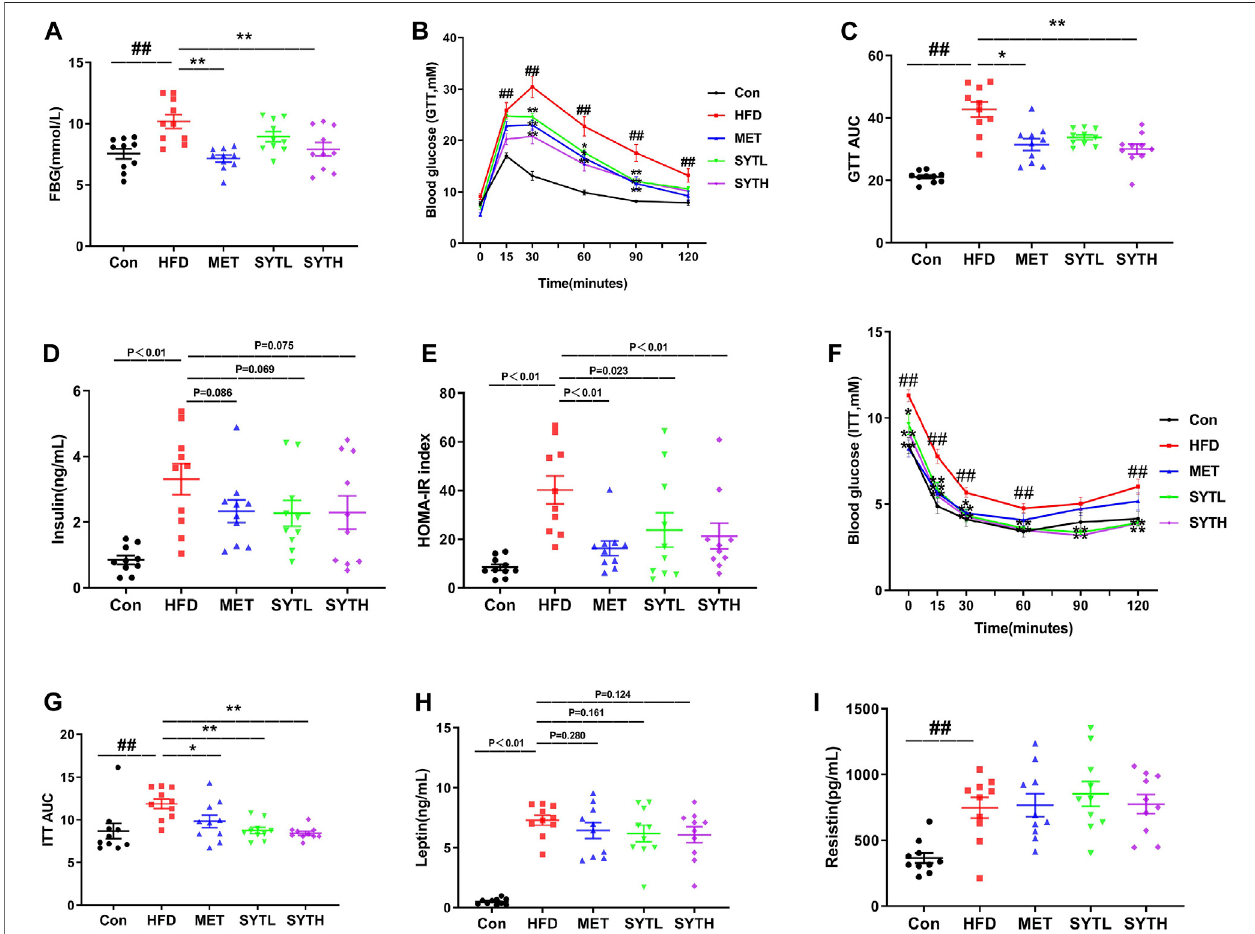
FIGURE 3 | SYT restores glucose tolerance and ameliorates IR in HFD mice. After treatment with SYT for 16 weeks, fasting blood glucose (A) was measured. At 20 w,GTT (B) wasmeasured,andAUCofGTTwasrepresented bydotplots (C) .Seruminsulin (D) and HOMA-IR index (E) weremeasured.ITT (F) wasmeasured,and AUC of ITT was represented by dot plots (F) . Serum leptin (H) and serum resistin (I) were determined. ## p < 0.01 compared with Con group; * p < 0.05, ** p < 0.01 compared with the HFD group.